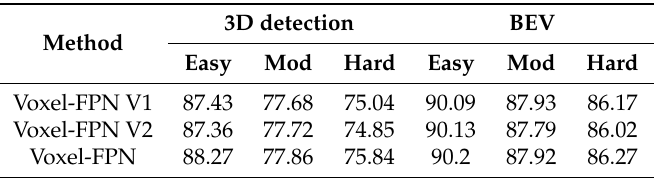
Table 5. Detection performances of different fusion strategies.